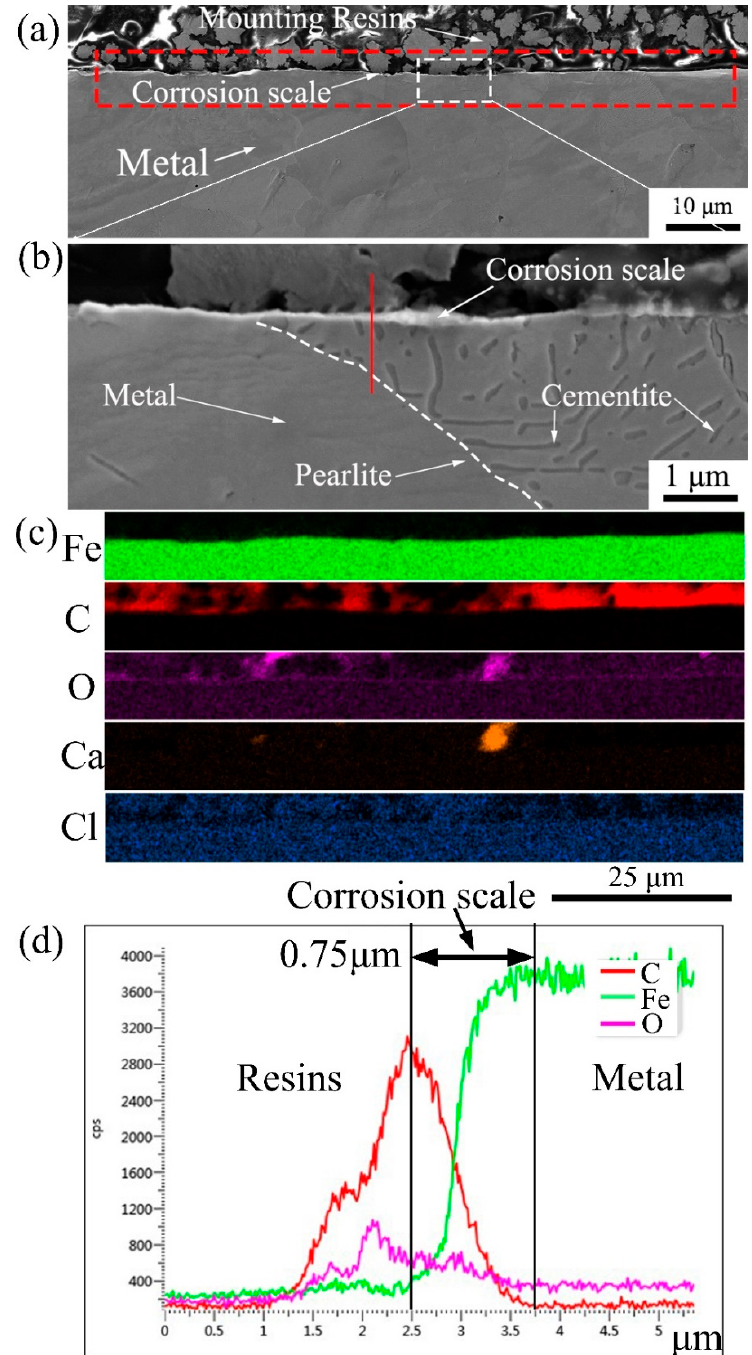
Figure 5. ( a ) SEM image of the cross-section formed on L245N standard steel after 1/2 day of testing; ( b ) the enlarged SEM image of the area in the white box in ( a ); ( c ) EDS mapping of the area in the red box in ( a ) and ( d ) EDS compositional profile along the red line marked in ( b ).